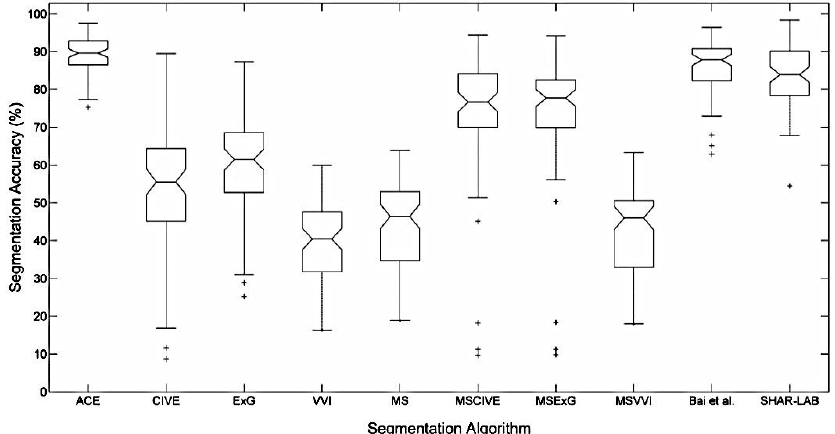
Figure 5. Boxplot of segmentation accuracy of all algorithms tested for the combined dataset. ACE has